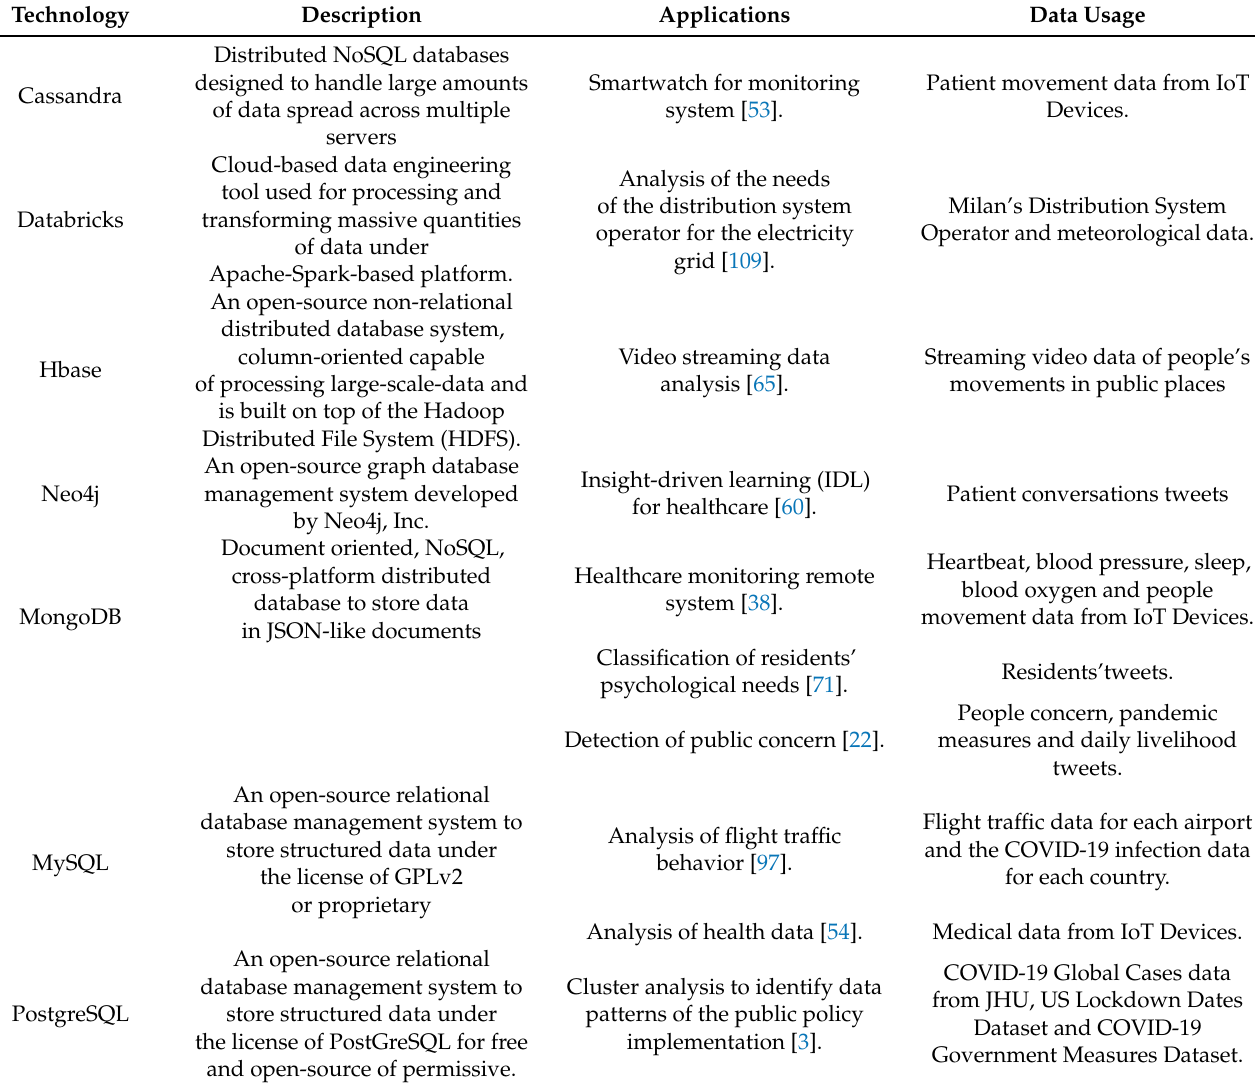
Table 2. Databases technology with their applications used by previous research.